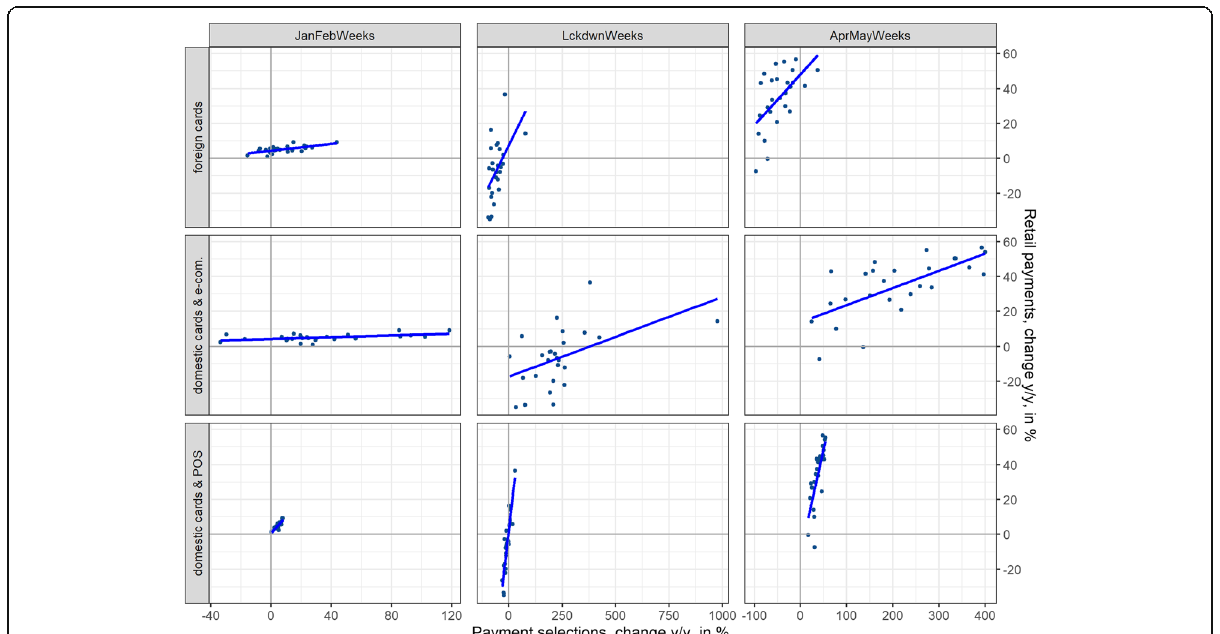
Fig. 5 Excess retail card payments (percentages) for foreign issued cards, domestic card-not-present payments, and domestic card-present payments (panels) versus total retail payments (percentages) per canton for the pre-lockdown (left), lockdown (middle), and post-lockdown (right) periods. Source: Own calculations, Worldline/SPS